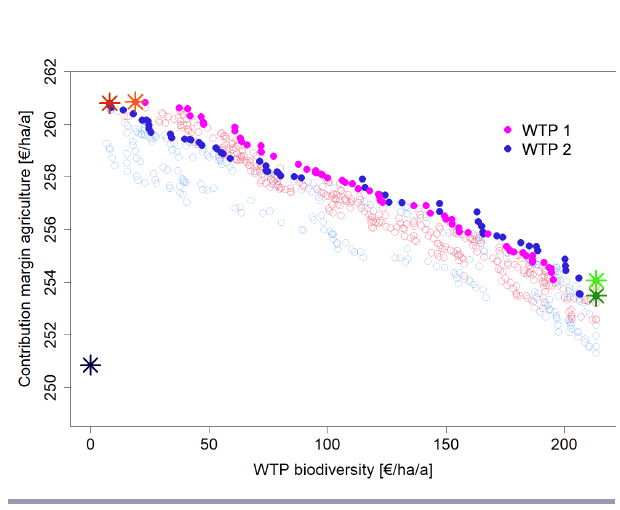
Fig. 5. Pareto frontiers based on the two willingness to pay (WTP) functions, WTP 1 and WTP 2. Each of the seven optimization runs per WTP function returned a set of Pareto- optimal solutions (light-colored, unfilled points). The nondominated solutions of these sets form the overall Pareto frontiers. Orange asterisks at the upper left indicate points with the highest WTP for agricultural production (WTP 1, light orange; WTP 2, dark orange) and green asterisks at the lower right indicate points with the highest WTP for biodiversity (WTP 1, light green; WTP 2, dark green). Blue asterisk = status quo.